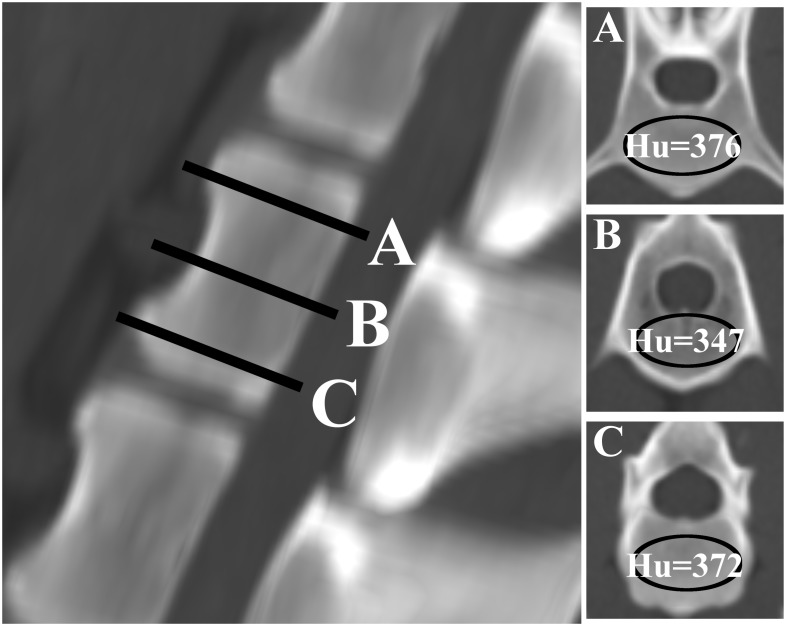
Computed tomography images demonstrating the method of determining vertebral HU as described by Schneider [19].The left image shows the sagittal reconstructed image at the level of the first lumbar vertebra. Slices A-C represent the levels for HU measurement. Slice A was taken just inferior to the superior end plate, slice B at the middle of the vertebral body, and slice C just superior to the inferior end plate. The images at the left (A-C) represent the axial images corresponding with slices A-C. An elliptical region of interest was used to determine HU values.